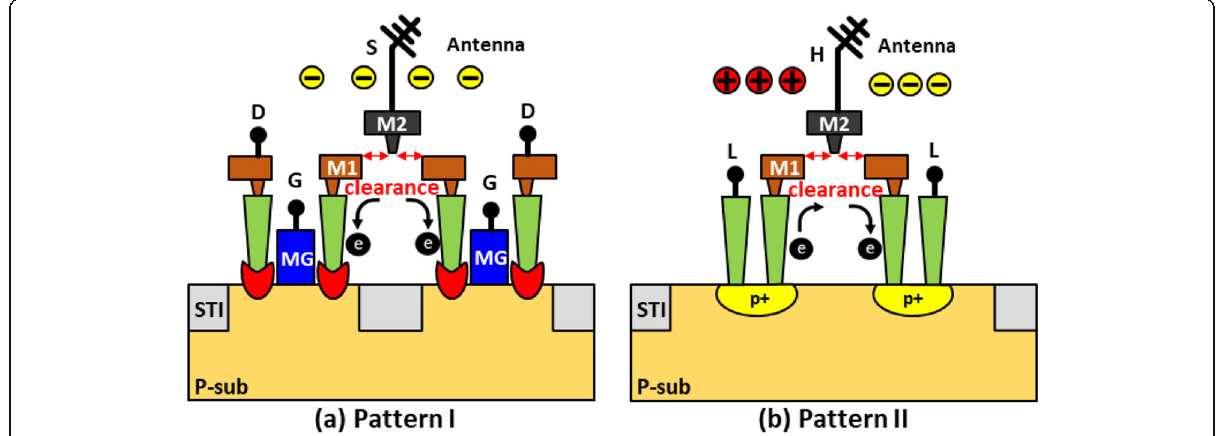
Fig. 2 Illustrations of newly proposed differential test patterns designed to accentuate the effect of latent damage caused by plasma induced a negative and b bi-directional stresses, where the clearance between metal layer to set to 14